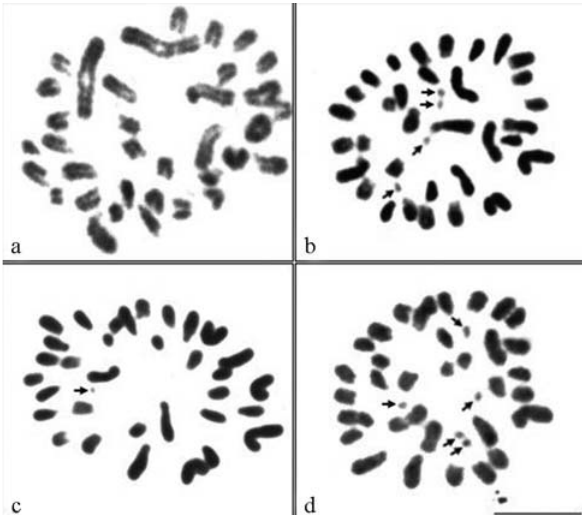
Figure 1 - Spermatogonial metaphases of Euchroma gigantea with differ- entchromosomenumbers:2n=36(a),2n=34(b),2n=33(c),and2n=32 (d). Arrows indicate punctiform B chromosomes in b, c and d. Bar = 10 μ